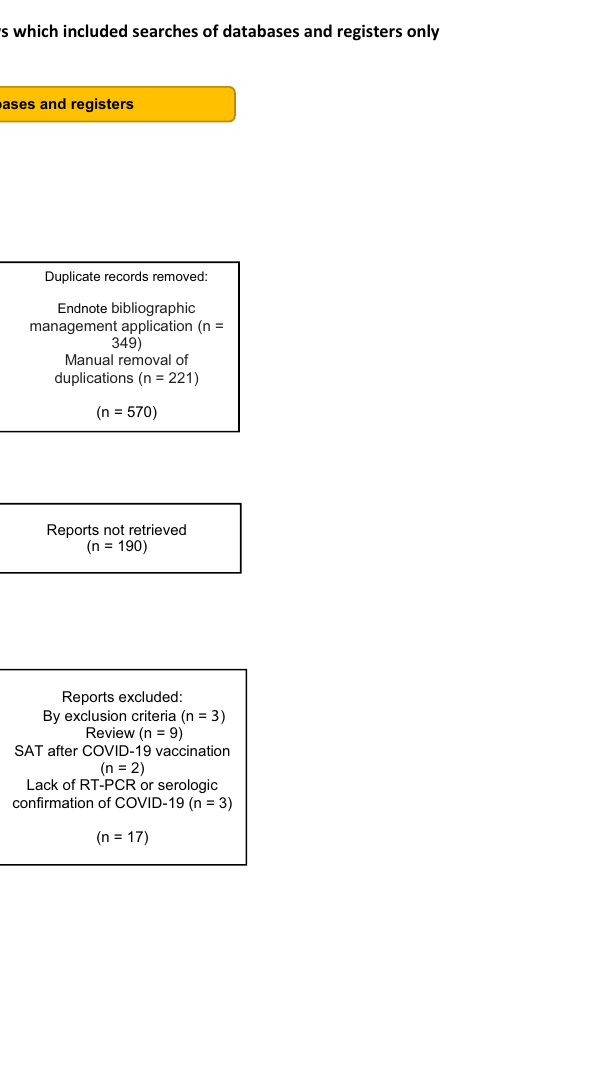
FIGURE 1 Preferred Reporting Items for Systematic reviews and Meta-Analyses (PRISMA) fl ow diagram of the study selection for the systematic